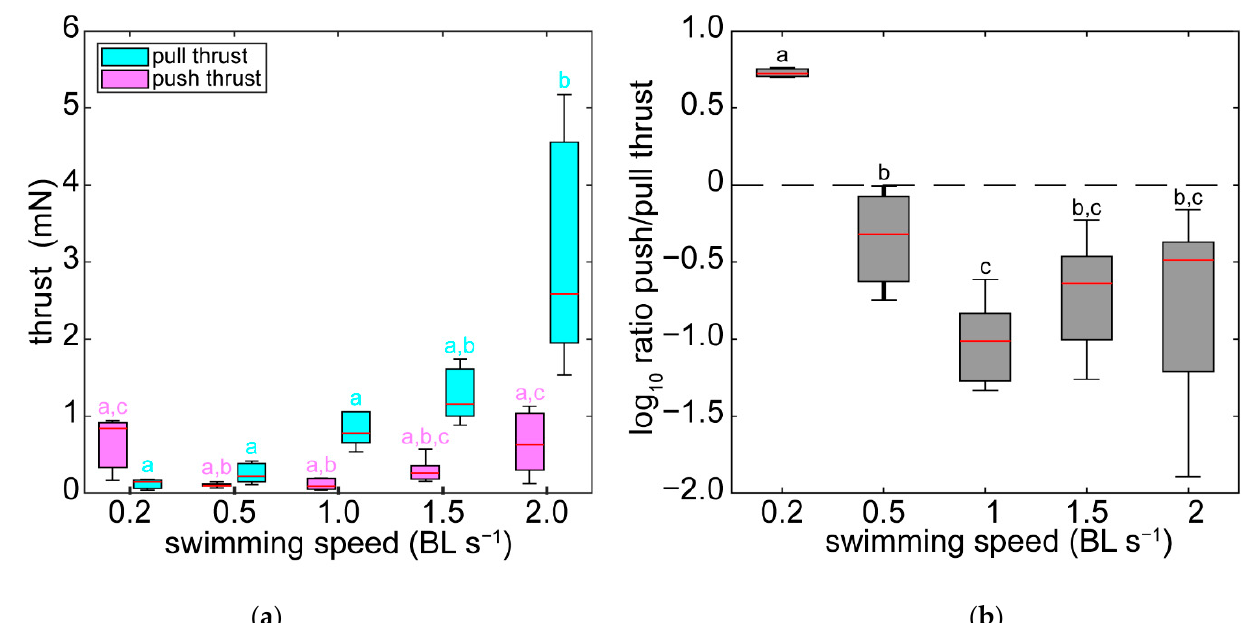
Figure 6. Contribution of push and pull forces to total thrust. ( a ) Boxplot diagram showing the magnitude of pull and push thrust forces for speeds ranging from 0.2 to 2.0 BL s − 1 . For each component of thrust, means identified by the same-colored letters are not significantly different ( p > 0.05). ( b ) Boxplot diagram showing the relative contribution of push and pull forces to thrust. A ratio greater than 0 indicates that thrust is primarily generated through push forces while a ratio less than 0 indicates that pull thrust is dominant.